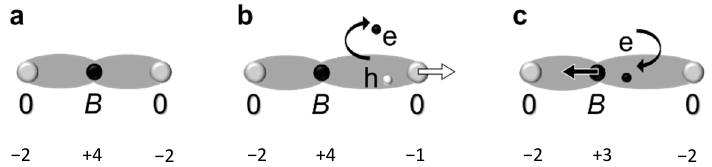
Figure 3. B -O lengths. Schematics for ( a ) regular AB O 3 , ( b ) hole polaron, and ( c ) electron polaron.